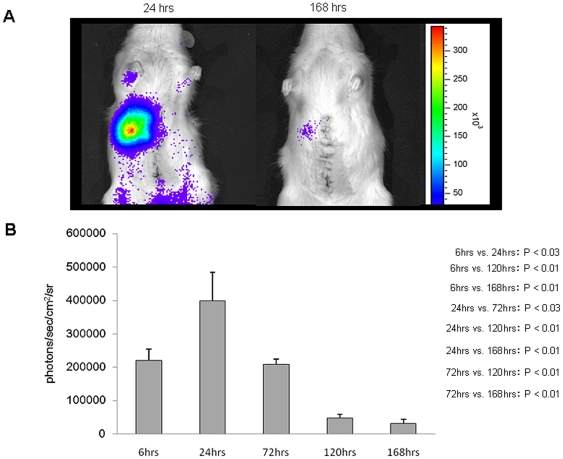
Decrease of luciferase activity.The expression level of luciferase was postoperatively observed using a noninvasive living image acquisition IVIS system. Accumulation of MSCs in the remnant liver. A. Most of the MSCs became trapped in the remnant liver. Thereafter, the luciferase activity diminished with time. B. The largest level of luciferase was 187272±119507 photons/sec/cm2/sr (sr = units of solid angle or steradian). (24 h vs. 168 h: P<0.03; 24 h vs. 120 h: P<0.05; 72 h vs. 168 h: P<0.05).